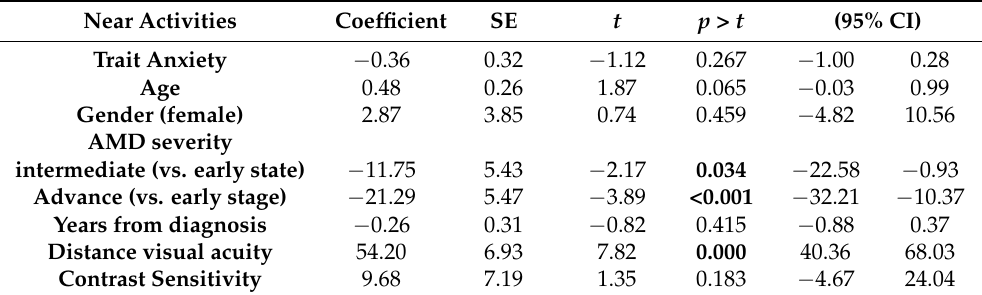
Table 4. Multiple linear regression model that correlates trait anxiety with the subscale Near Vision from the quality-of-life questionnaire